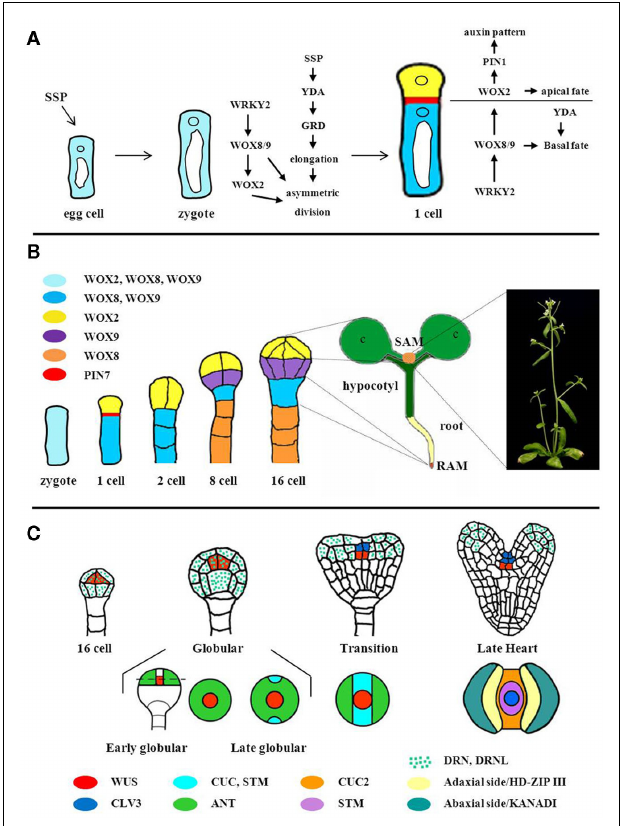
FIGURE 2 |Apical pole establishment during embryogenesis. (A) Gene interactions during the asymmetric division of the Arabidopsis zygote. SSP mRNA acts as a signal delivered by the pollen to promote elongation and asymmetric division of the zygote via theYDA pathway.The WRKY/WOX pathway promotes polar organelle localization in and asymmetric division of the zygote.Vacuoles (white), nuclei (circles) are indicated. Expression domains and PIN7 localization are color-coded as shown in (B) . Modified from Zhang and Laux (2011). (B) Apical and basal lineage development.The zygote co-expresses WOX2 , WOX8 , and WOX9 , the expression patterns of which subsequently mark the gradual establishment of the body plan. RAM, root meristem primordium; SAM, shoot meristem primordium. (C) Partitioning of the apical embryo domain. Upper row: longitudinal views of embryos, displaying WUS , CLV3 , and DRN , DRNL expression patterns. Bottom row: top views of embryos. Expression domains of marker genes showing the gradual establishment of bilateral symmetry are indicated. Figure modified from Laux et al. (2004). For references and gene symbols see